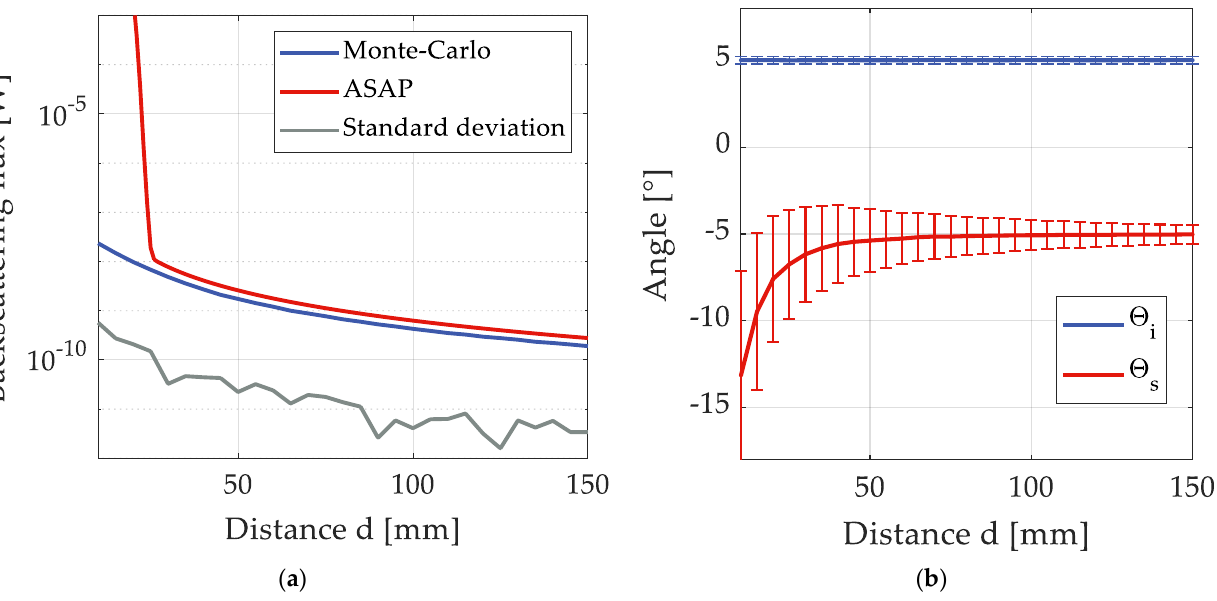
Figure 7. The backscattering behavior of a superpolished spherical cap. ( a ) The backscattering as a function of distance d. the gray curve is standard deviation of Monte-Carlo estimation. ( b ) the angle of incidence and scattering angle with respect to the distance and the corresponding standard deviation for different position.